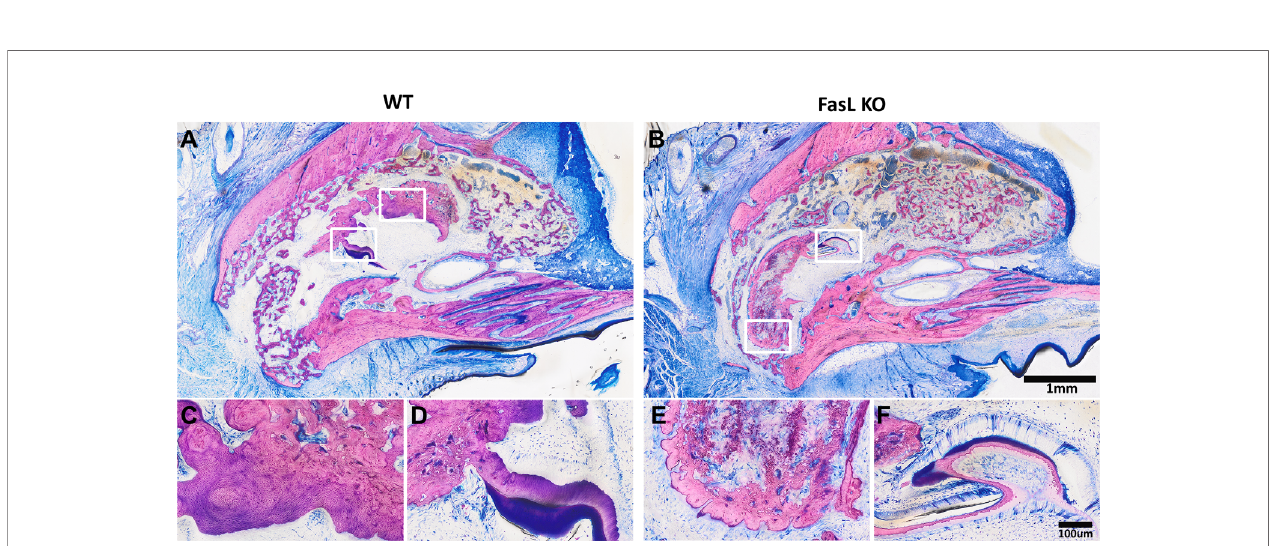
FIGURE 5 | The WT (A) and The FasL KO (B) mice revealed a structure like a growing tooth located at different areas of the alveolar socket in the overview image (2x). A higher magni fi cation (20x) evidenced the “ osteodentin mass ” with dentin tubules (C, E) and enamel structure (D, F) .